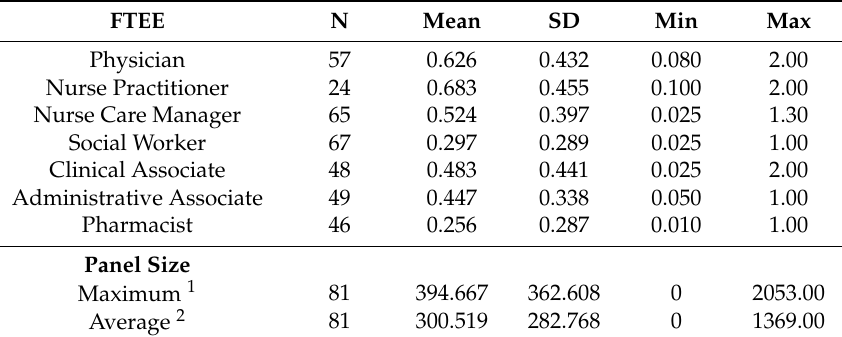
Table 2. GeriPACT Staff FTEE and Panel Size (N =